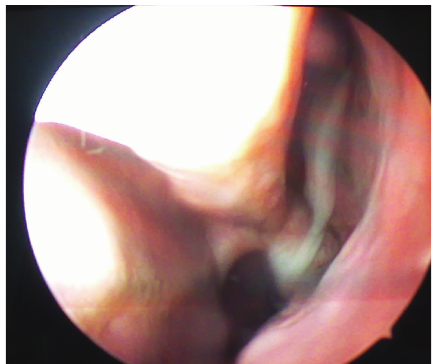
Figure 3: Diagnostic nasal endoscopy showing thick pus trickling down into the nasopharynx.